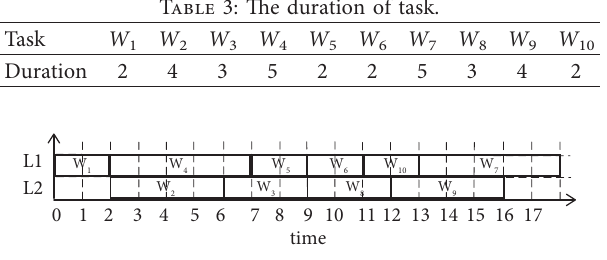
Table 3: The duration of task. Task